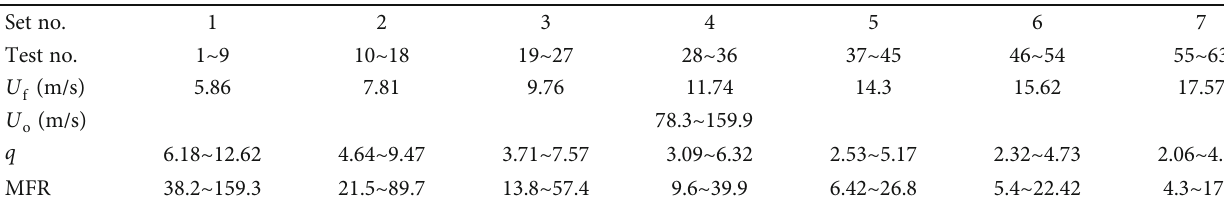
Table 1: Flow conditions in all the test cases for experiments.